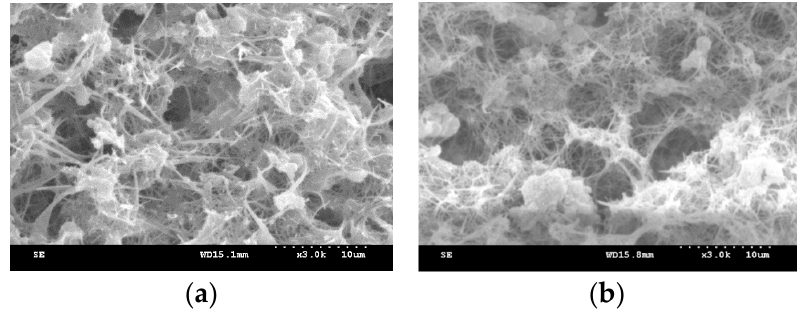
Figure 1. The scanning electron microscope (SEM) photos of the superhigh-water content material concretion (SCMC) micro-characteristics with different water volume percentage. ( a ) Water volume percentage of 95%; ( b ) water volume percentage of 97%.